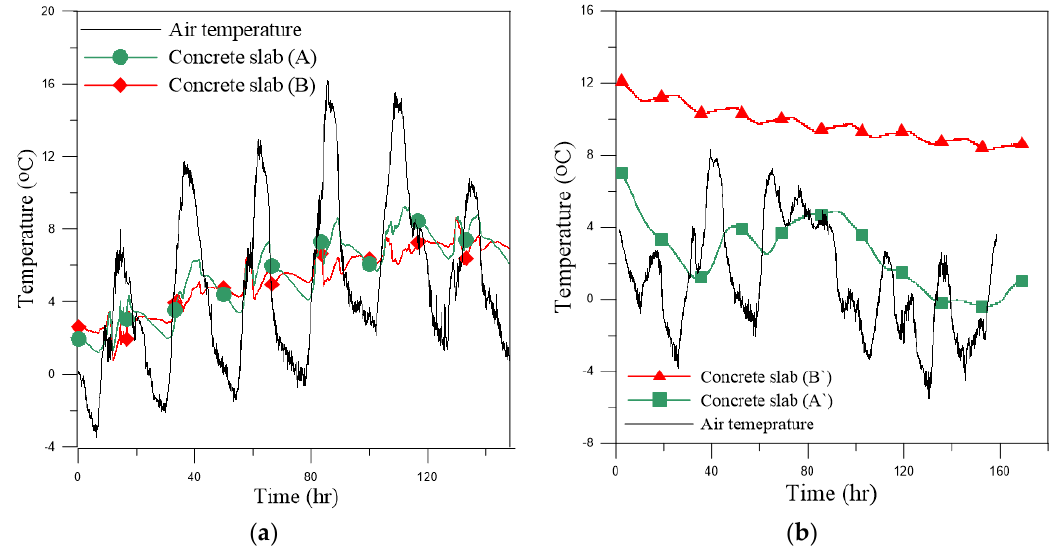
Figure 15. Temperature variation according to depth at center of each high-density polyethylene (HDPE) energy slab (for location of A, B, A` and B` refer to Figure 3). ( a ) Wall-type energy slab (HDPE, without thermal insulation); ( b ) Floor-type energy slab (HDPE, with thermal insulation).